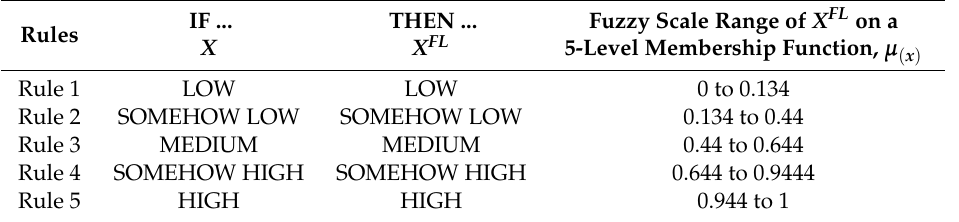
Table 3. Sample fuzzy rules used in the experiment to transform the original data X on a Likert scale to their corresponding fuzzy Likert features, X FL .